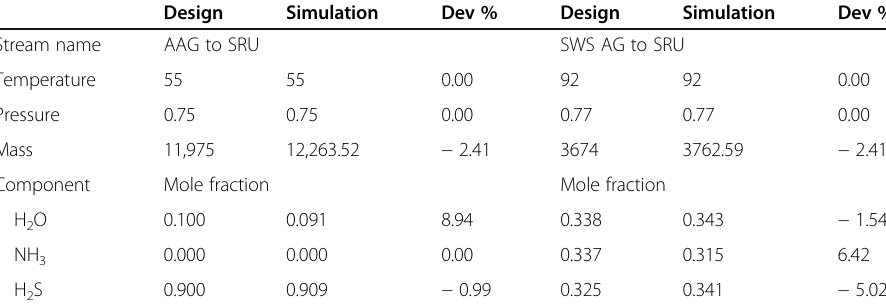
Table 6 Validation